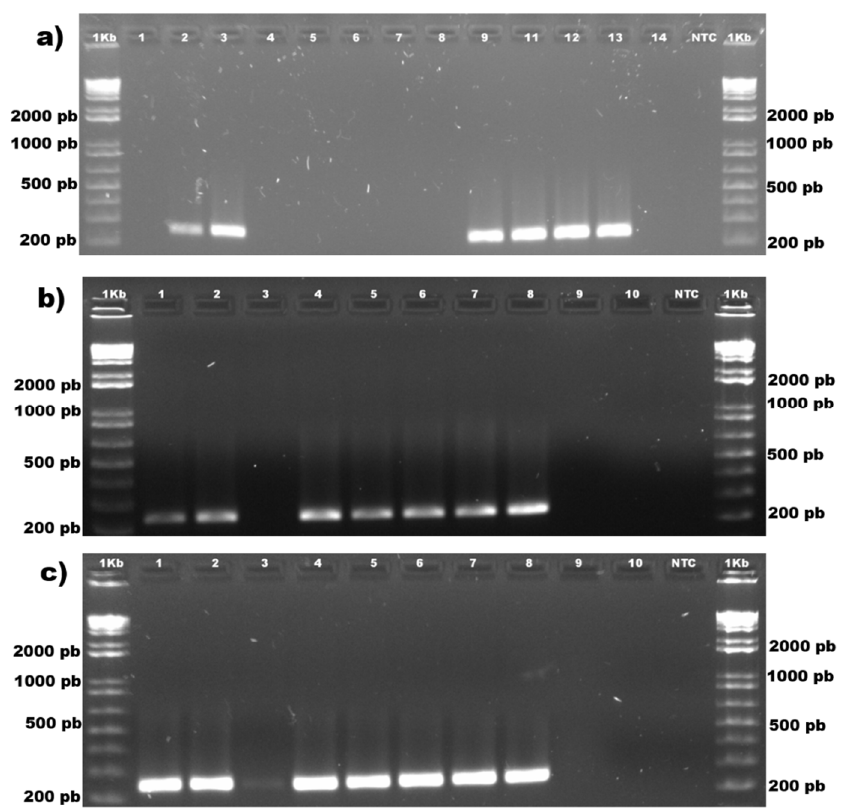
Figure 7. Kretzschmaria zonata detection using the primer set KZ-AQ-3F/KZ-AQ-3R. ( a ) DNA amplifi- cation products from asymptomatic teak tree samples from field area A; the 1 Kb lanes are for the DNA marker (1 Kb DNA ladder); positive bands at 241 bp; lanes 1–12: samples from symptomless